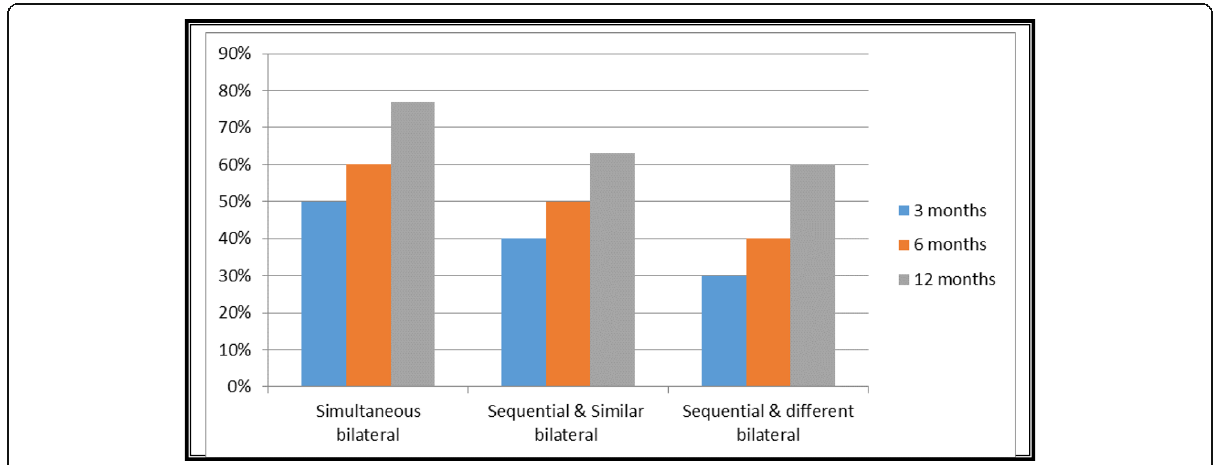
Fig. 3 Comparison of HCST at 3, 6, and 12 months for post-lingual group